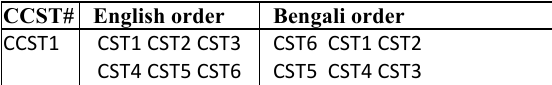
Table 3 Example of CSTs alignment